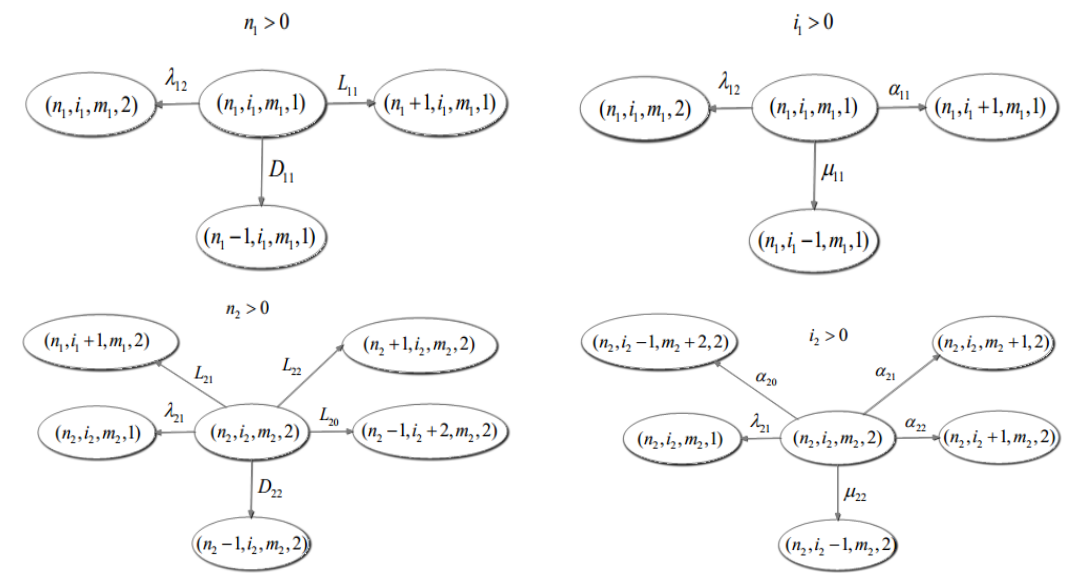
Figure 1. State transition